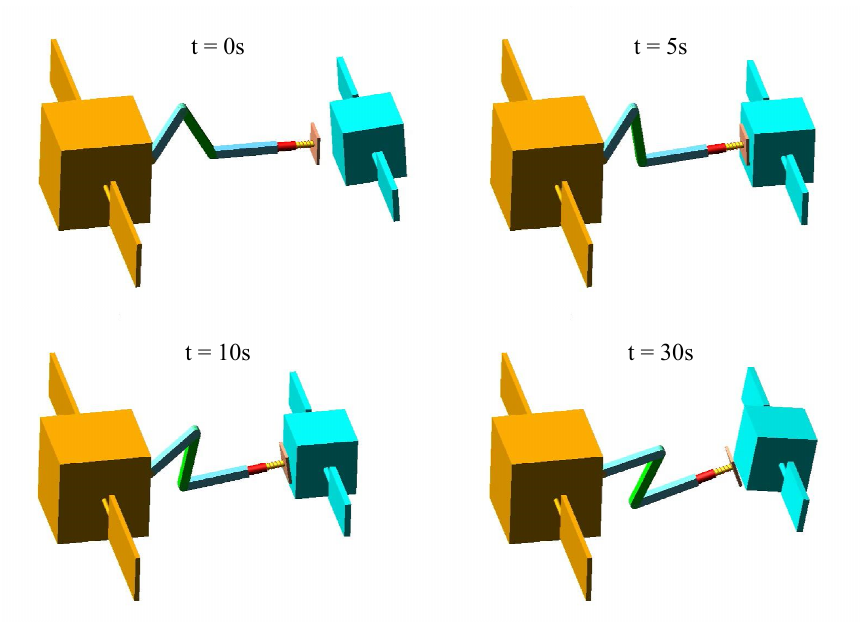
Figure 11. The chaser and target spacecraft during the contact phase using the PD control and impedance control independently.